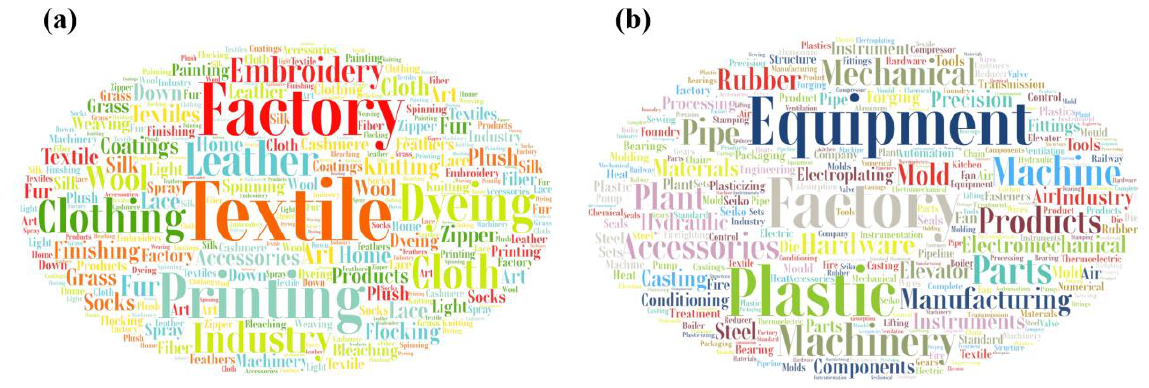
Figure 3. Related keyword examples for different industrial structures: ( a ) textile and clothing man- ufacturing; ( b ) equipment manufacturing. manufacturing; ( b ) equipment